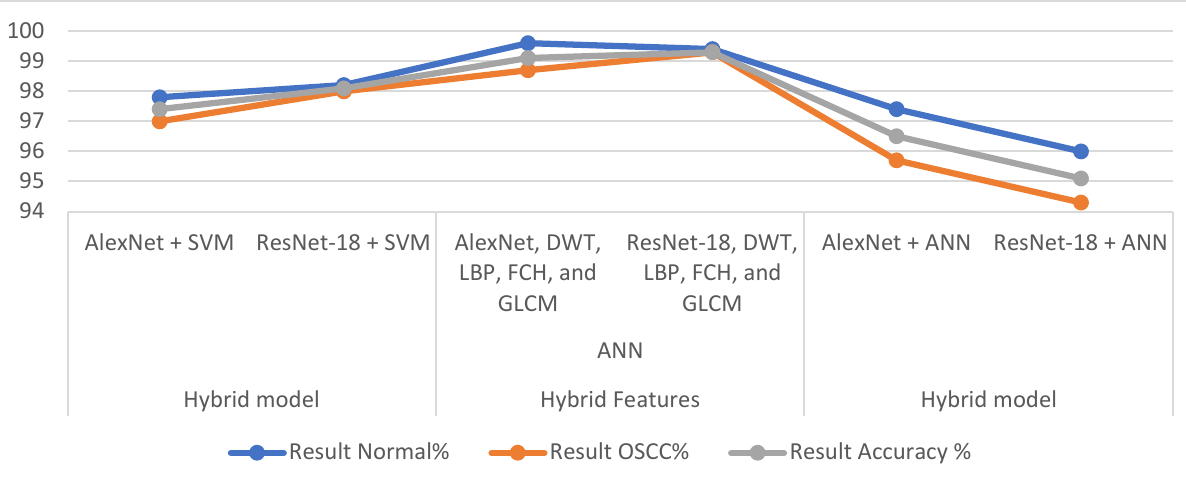
Figure 16. Performance of the proposed methods for OSCC data set diagnostics.